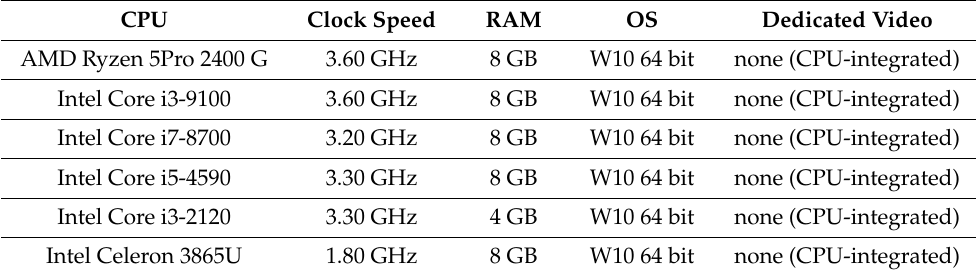
Table 2. The different computer devices employed in the Caltagirone digital pathology lab for the pathologists’ workstations. CPU, central processing unit; RAM, random-access memory; OS, operating system; W10, Windows 10 (Microsoft, Redmond, WA,